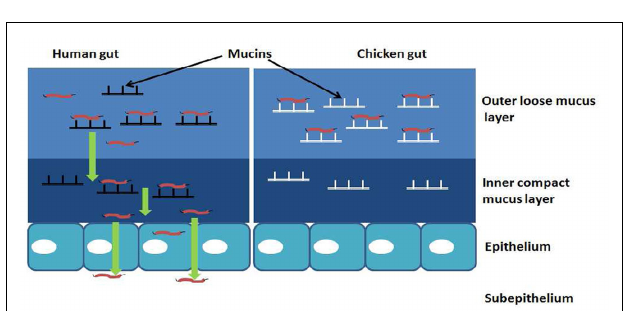
FIGURE 2 | Purified chicken intestinal mucins attenuate C. jejuni invasion depending on the region of the chicken gut from which mucins were isolated (Alemka et al., 2010b, reproduced with permission). C. jejuni was pre-incubated with mucins prior to infecting HCT-8 cells. Cae, mucin from the cecum; SI, small intestinal mucins; LI, large intestinal mucins. *Denotes significant difference compared to control. Cae p < 0.05, p < 0.005 for SI and LI. Hundred percentage mucin represents 1mg/ml.